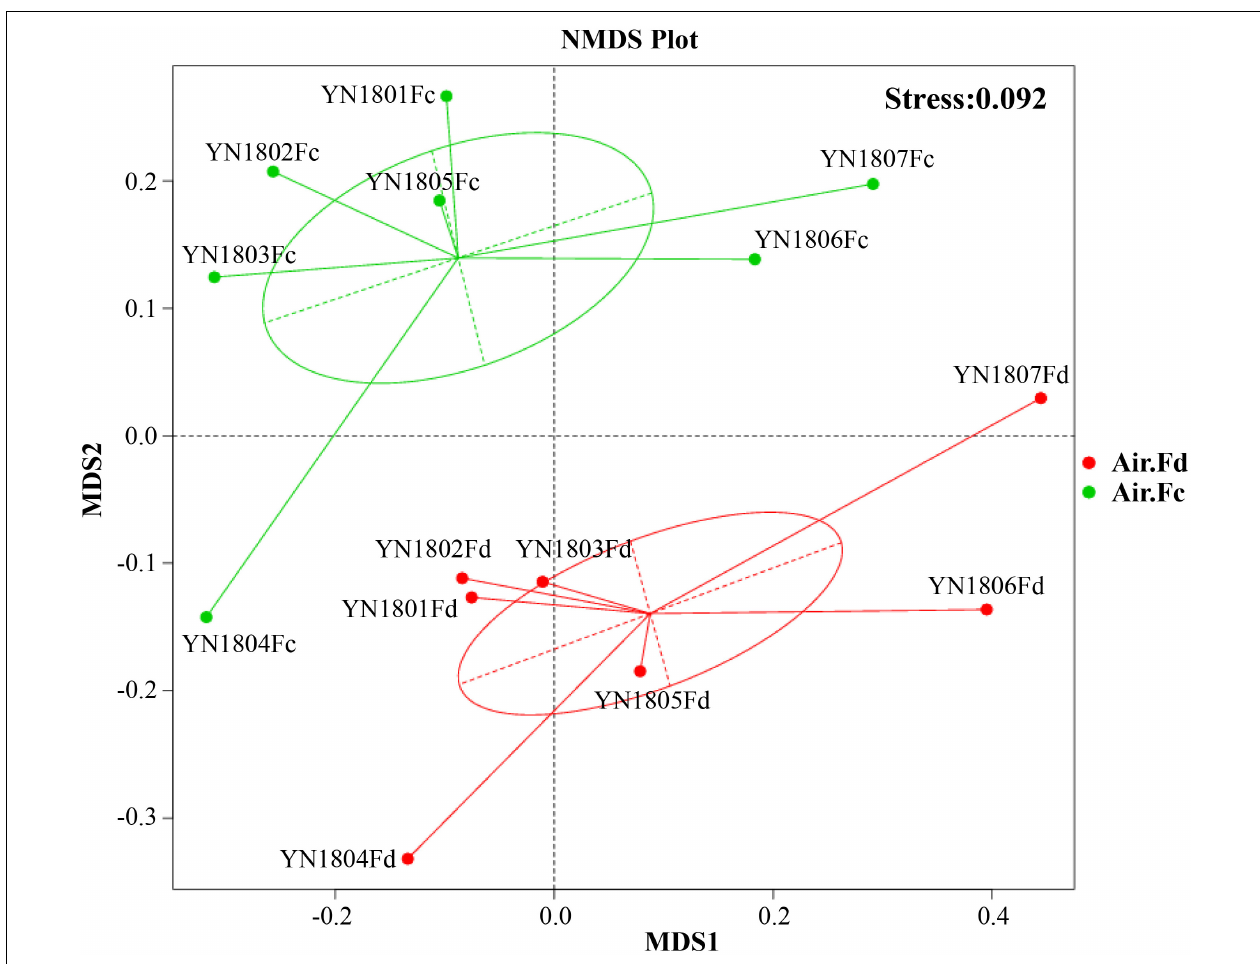
FIGURE 1 | Bray–Curtis matrices visualized using non-metric multidimensional scaling (NMDS) analysis showing distribution of rDNA (red dots, Air.Fd) and rRNA (green dots, Air.Fc) sequencing samples of fungal communities in the atmosphere.